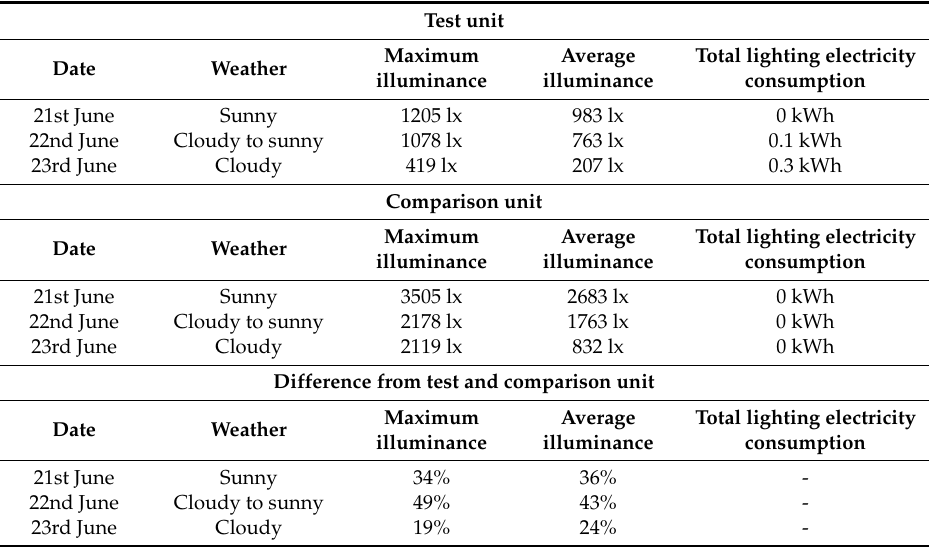
Table 3. Lighting test results.